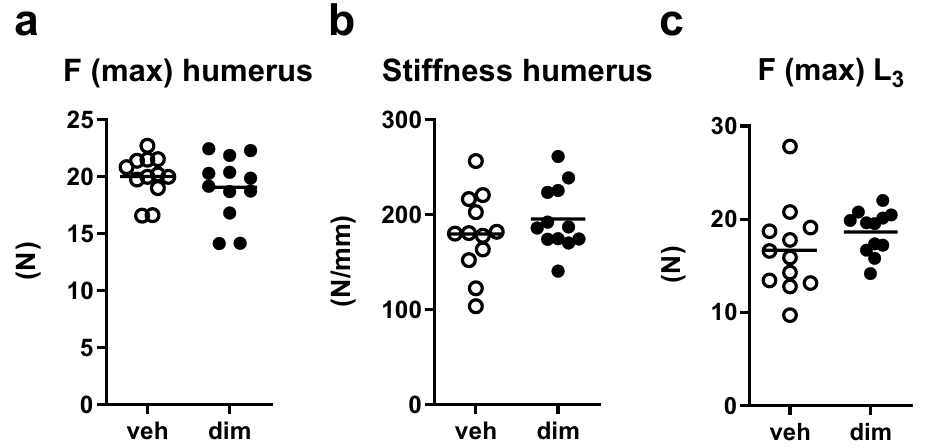
Figure 5. Long-term adipose tissue loss did not affect biomechanical properties of bone. ( a ) Ultimate strength (F (max)) and ( b ) stiffness of the humerus, determined by 3-point bending, and ( c ) ultimate strength of vertebra L 3 , determined by compression test. Symbols in the scatter plots represent individual mice and the bars indicate arithmetic mean. dim, dimerizer; veh, vehicle. n = 12 veh and 12 dim mice. ( a – c ) Student’s t-test.